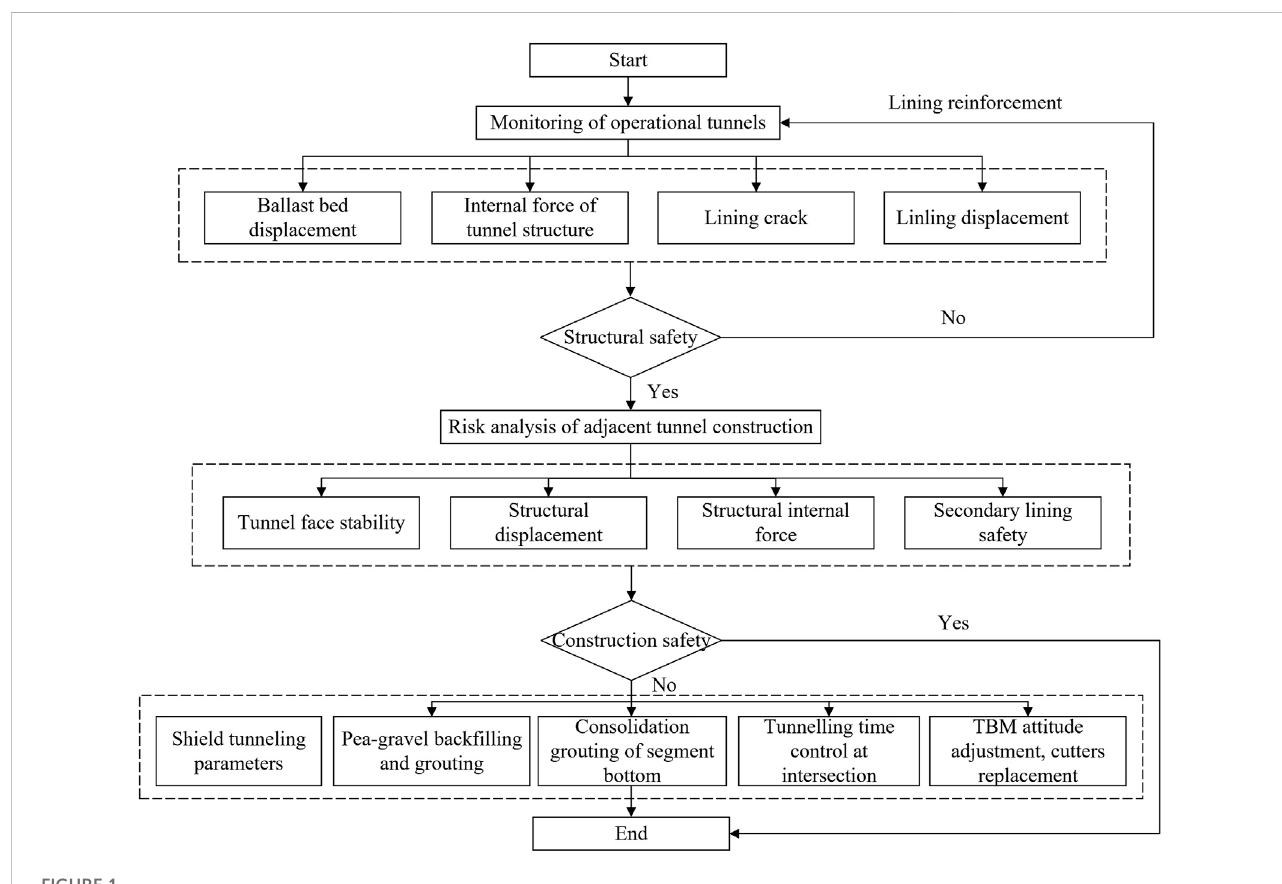
Risk control process of adjacent tunnel construction.